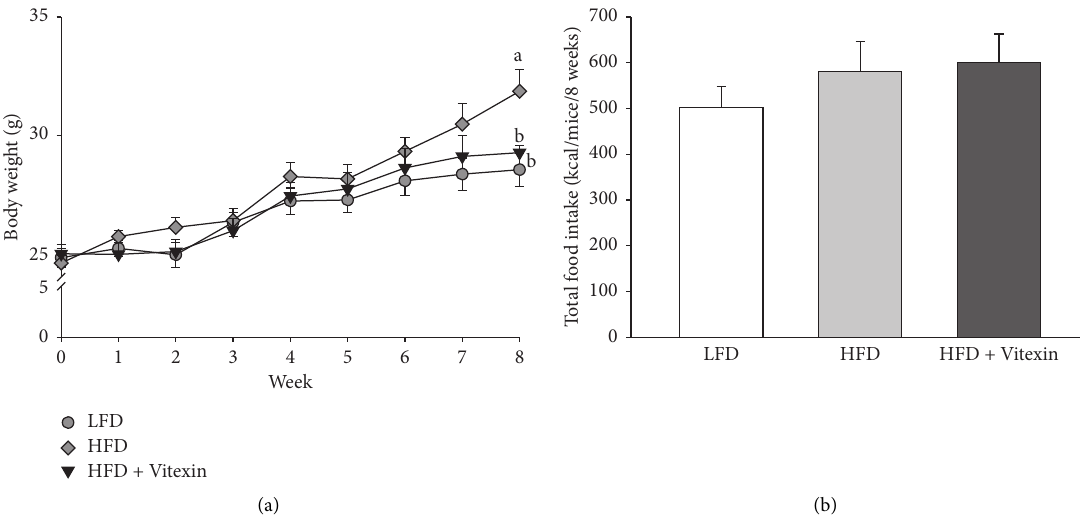
Figure 1: Influence of vitexin on body weight and food intake. Mice were fed with low-fat diet (LFD), high-fat diet (HFD), or HFD supplemented with 5 mg vitexin/kg BW/day (HFD+Vitexin) for 8 weeks. (a) Body weight monitored weekly; (b) total food intake. Numbers indicate mean ± SE ( n � 8 − 9 for (a) and n � 3 for (b)). Means with different letters were significantly different at P < 0 .